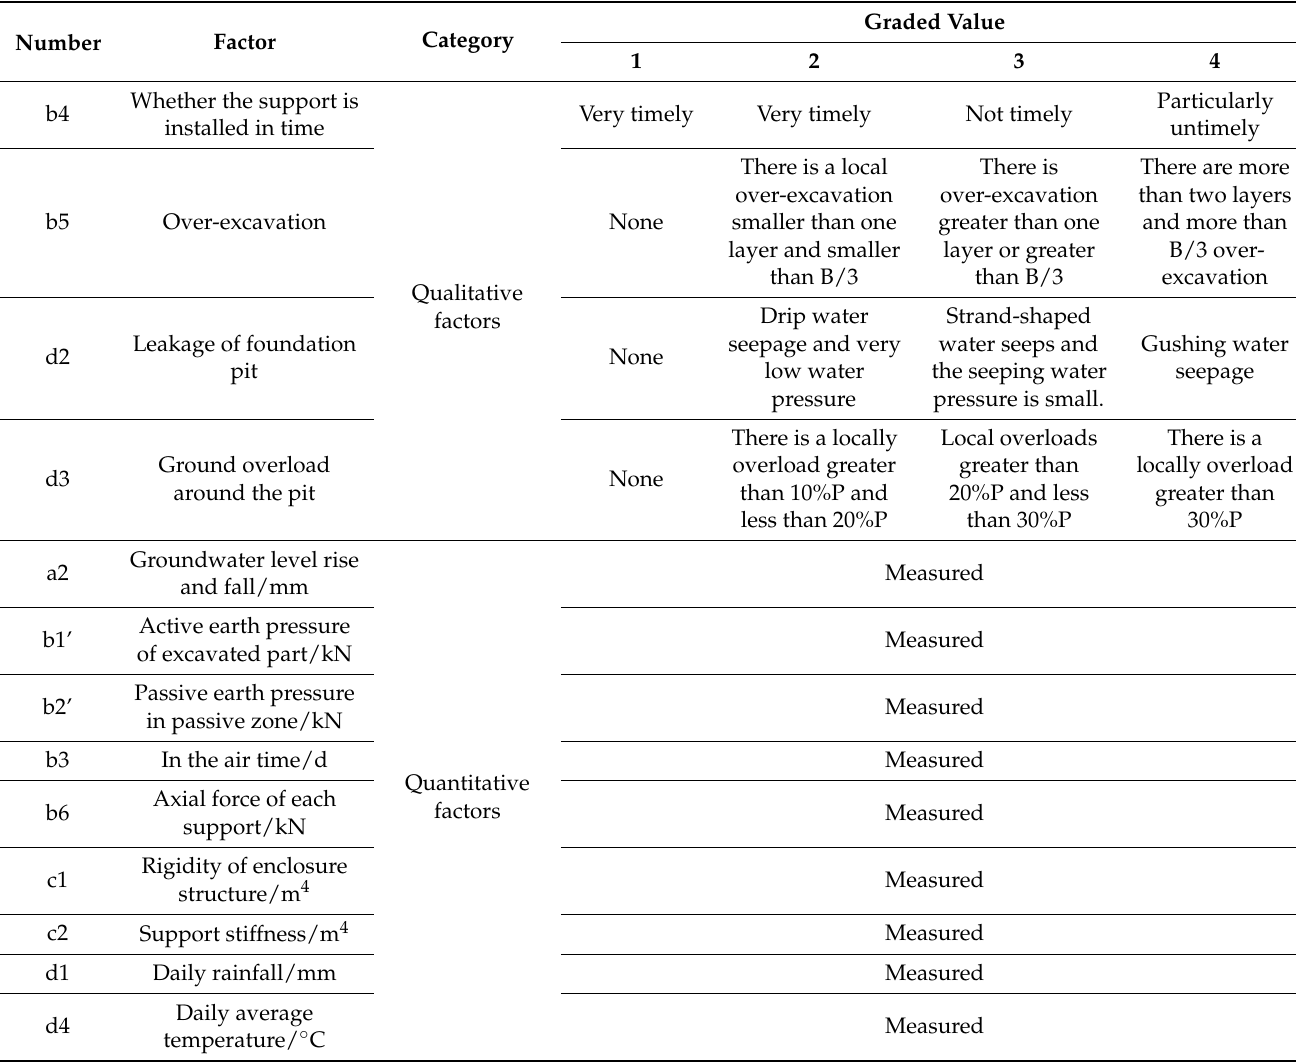
Table 2. Quantification of influencing